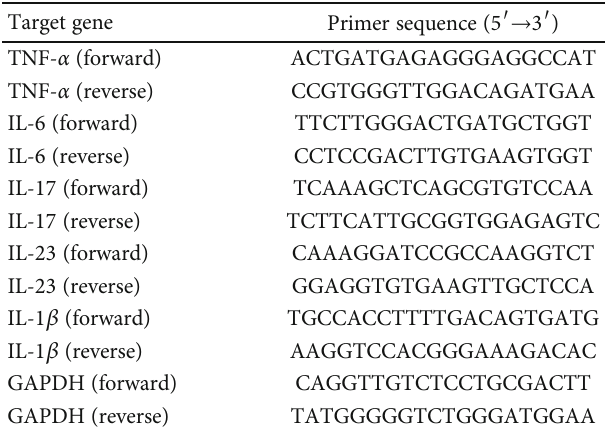
Table 1: Primer sequences of target